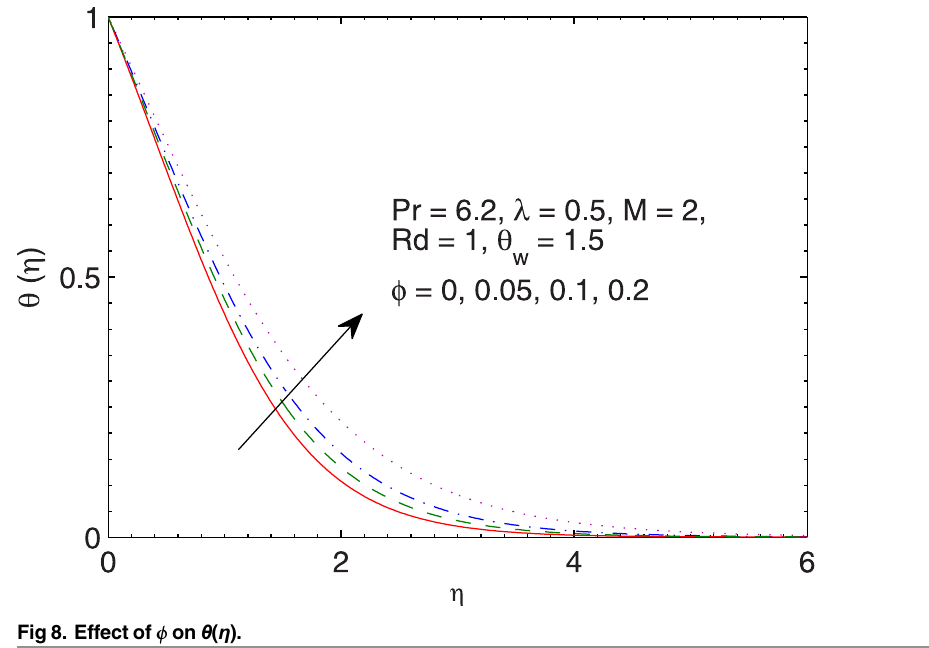
Fig 8. Effect of ϕ on θ ( η